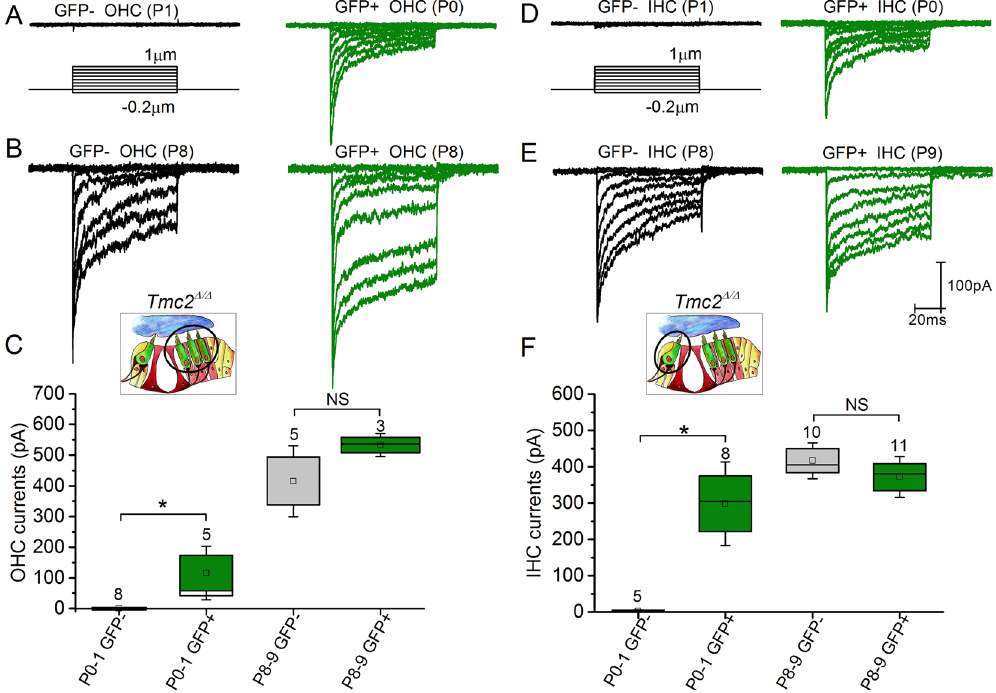
Figure 3. Sensory transduction currents in Rosa26 tm ( CAG-LSL-Tmc2-IRES-GFP ); Tmc2 Δ / Δ mice. ( A – C ) Sensory transduction currents were recorded from P0-P8 GFP-positive and GFP-negative OHCs of Rosa26 tm ( CAG-LSL-Tmc2-IRES-GFP ) ;Gfi1 Cre/ + ;Tmc2 Δ / Δ mice. While absent in GFP-negative P0 apical OHCs, large currents were recorded in P0-P1 apical GFP-positive cells. Non-significant difference was noted by P8. ( D,E ) Sensory transduction currents were recorded from P0-P9 GFP-positive and GFP-negative IHCs. While absent in GFP- negative P0 apical OHCs, large currents were recorded in P0-P1 apical GFP-positive cells. There was no significant difference at P8-P9. Number of cells is indicated for each group. Mean ± S.E.M. ** p < 0.01; NS p > 0.05 (one way